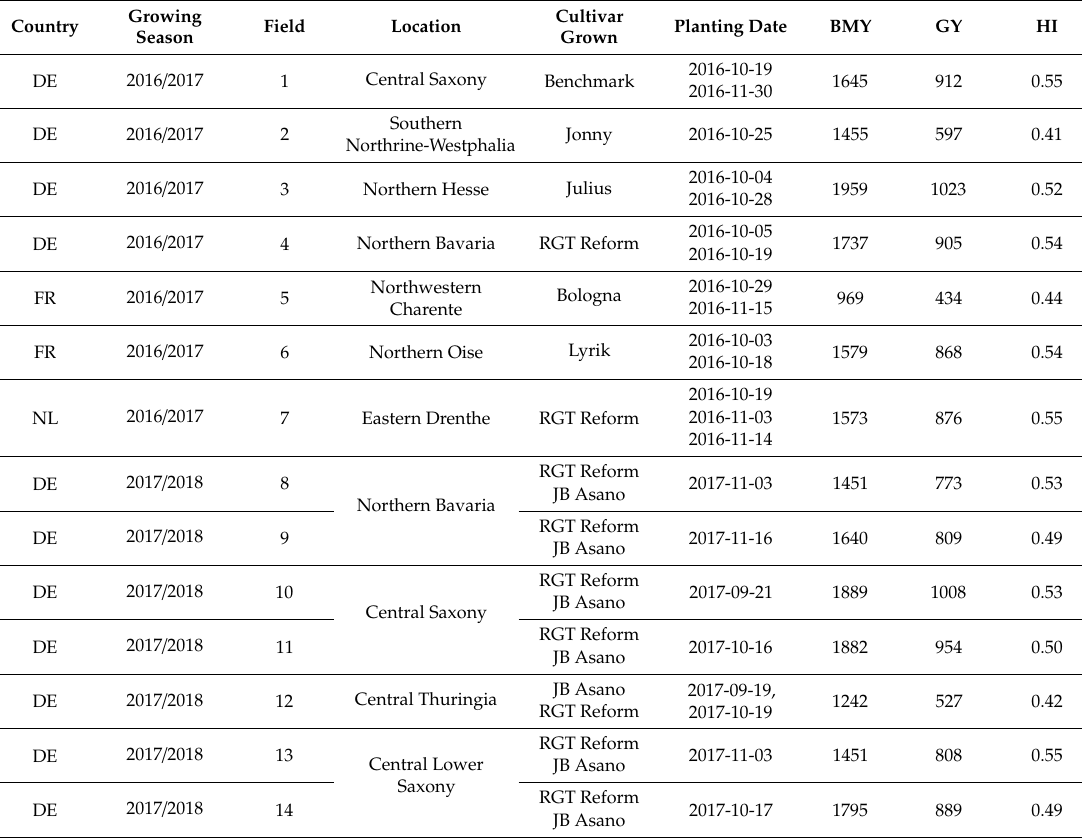
Table A1. List of study fields and their respective locations. BMY: average total aboveground biomass yield (g m -2 ), GY: average grain yield (g m -2 ), HI: harvest index, DE: Germany, FR: France, NL: